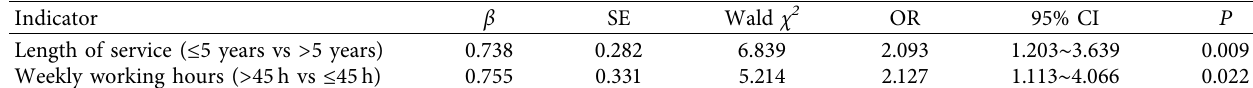
Table 4: Multivariate analysis of the influencing factors of workplace violence that ICU medical staff suffered. Indicator β SE